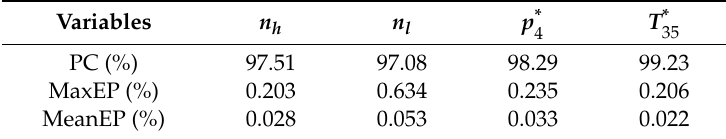
Figure 11. Command signals of (a) T ∗ a and (b) p ∗ a . Table 2. Simulation results on test data